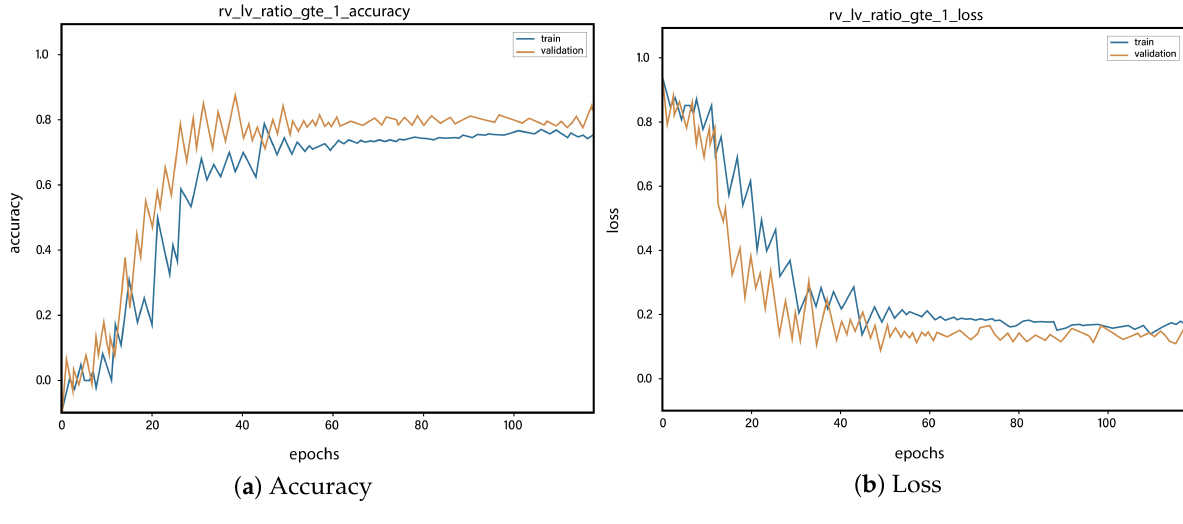
Figure 6. Training vs. validation accuracy and loss for the class: Right-ventricle/left-ventricle ratio greater than 1 PE.